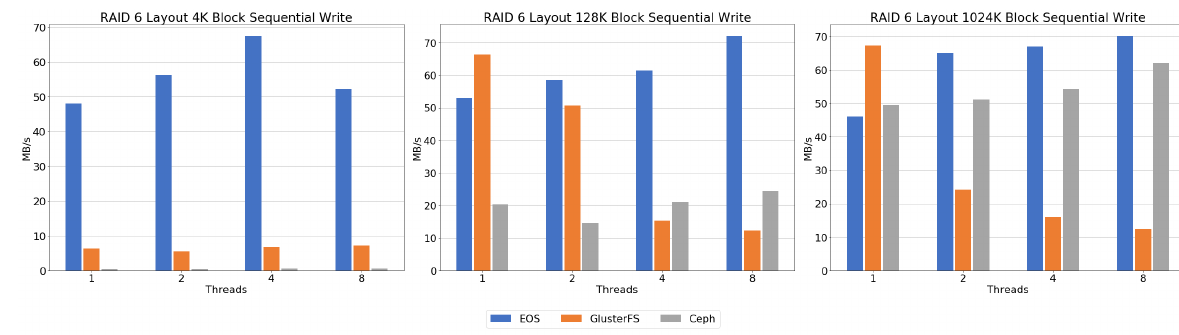
Figure 15. RAID 6-like layout—sequential write result.